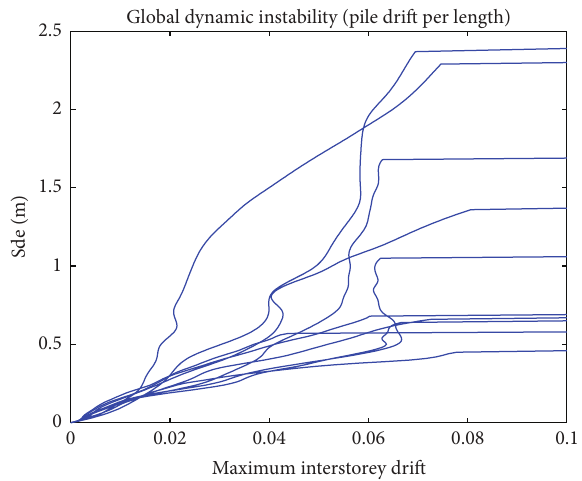
Figure 17: Multirecords IDA curve for original platform.